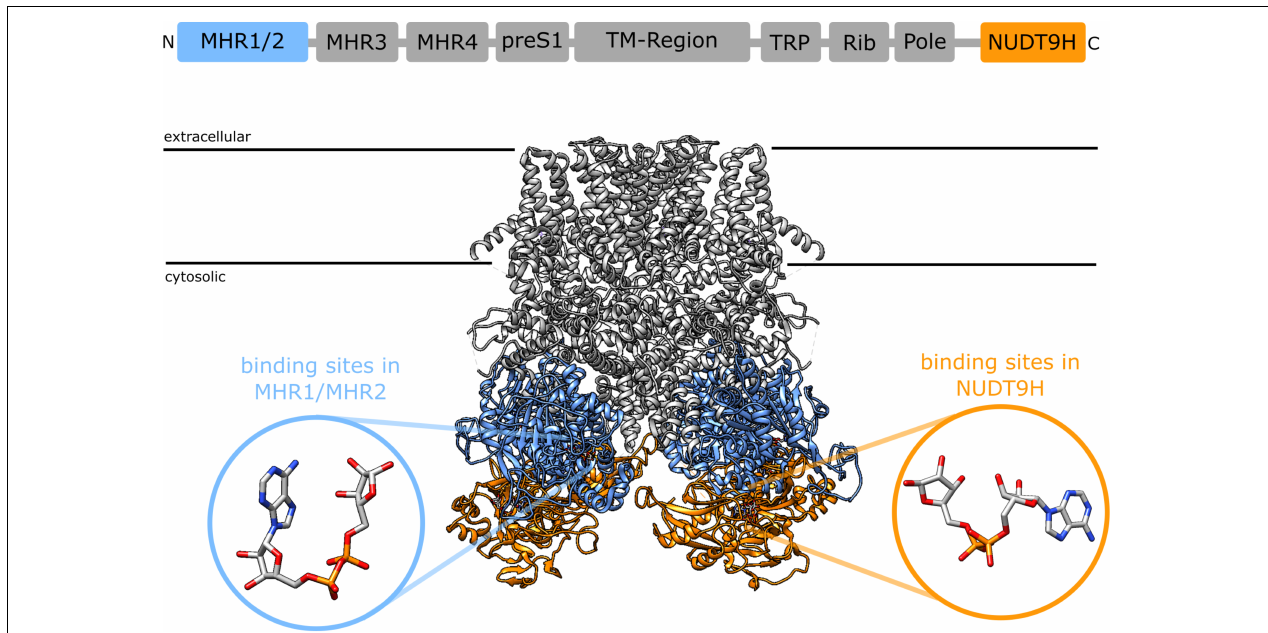
FIGURE 1 | Domain structure of TRPM2 [after (46)] and location of the two nucleotide binding sites in the cryoEM structure of human TRPM2 [pdb: 6PUS, (48)]: the recently identified N-terminal binding site between the MHR1 and MHR2 domains (blue) and the established C-terminal binding site in the NudT9H domain. The insets show the different conformation of ADPR in the binding sites as determined from the cryoEM structure, the ADPR in the N-terminal binding site assumes a horseshoe like conformation whereas the ADPR in in the NudT9H domain has a more elongated conformation. The depicted ADPR molecules have been reoriented relative to the TRPM2 structure to better illustrate the difference in conformation between the two binding sites. In a structure that has been solved in the presence of 8-Br-cADPR, 8-Br-cADPR occupies the N-terminal binding site between MHR1/MHR2